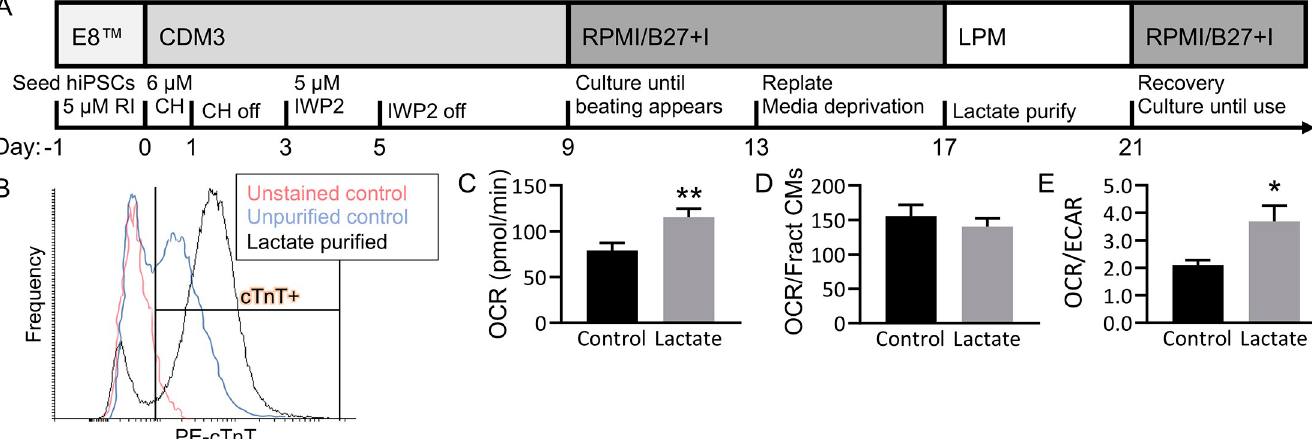
PLOS ONE | https://doi.org/10.1371/journal.pone.0230001 March 10,